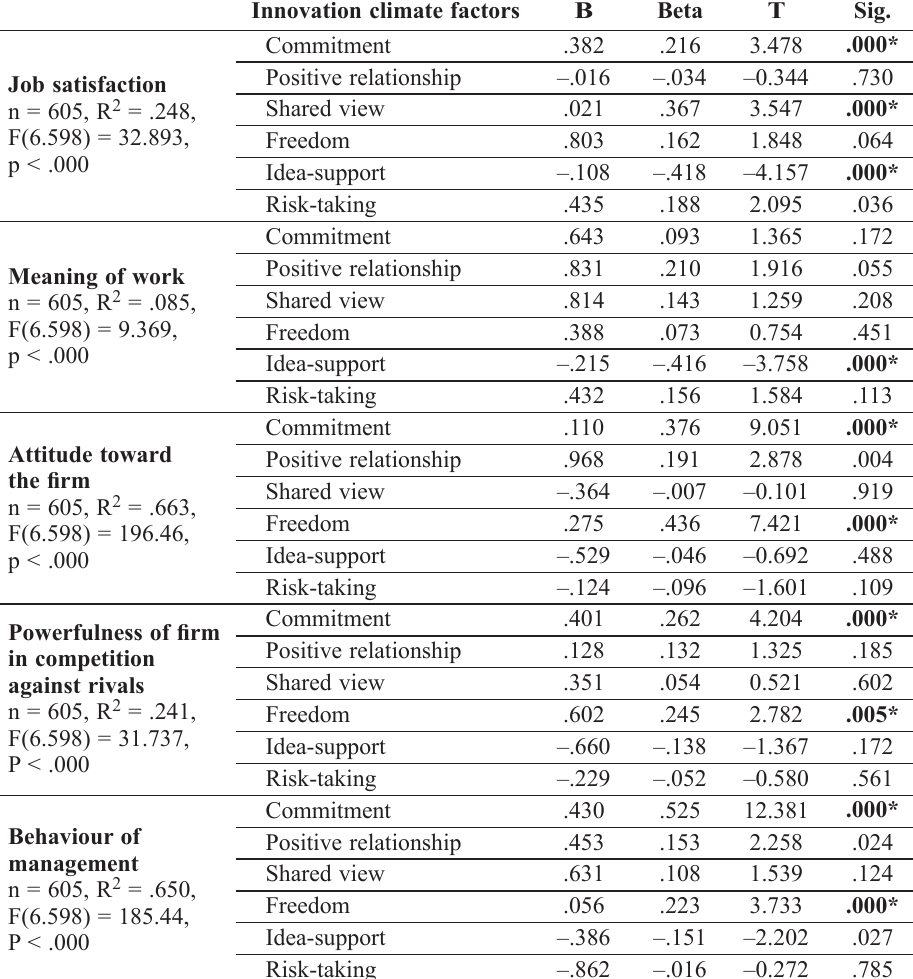
Table 5. Connections between the innovation climate and individual and organisational level factors in Slovakia (according to standardised regression coefficient Beta) Innovation climate factors B Beta T